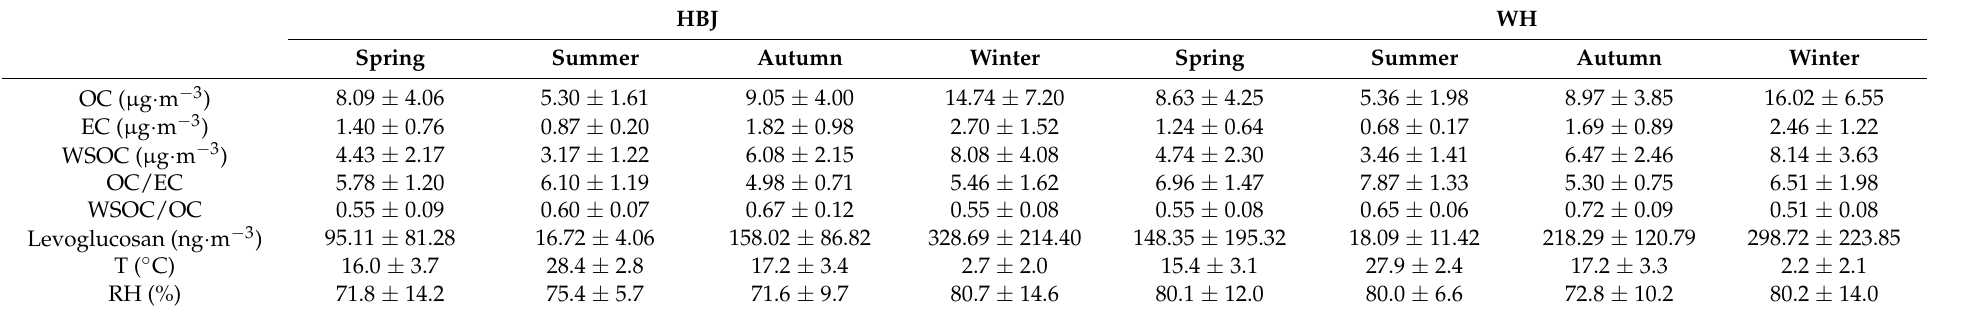
Table 1. Concentrations of OC, EC, WSOC, and levoglucosan in PM 2.5 in Bengbu.